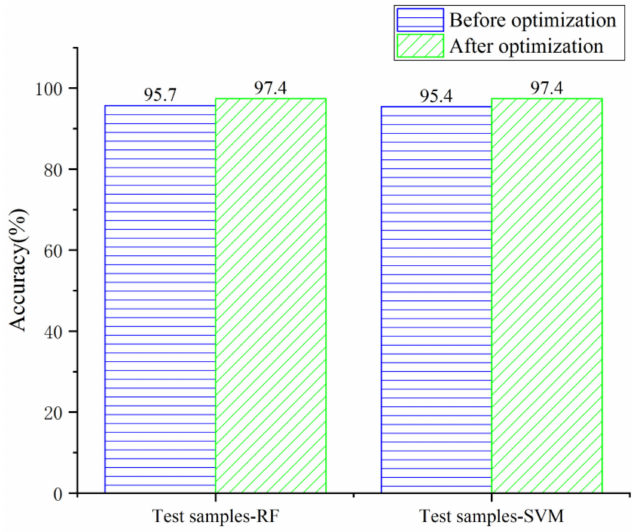
Figure 5. Comparison of test samples’ accuracy before and after